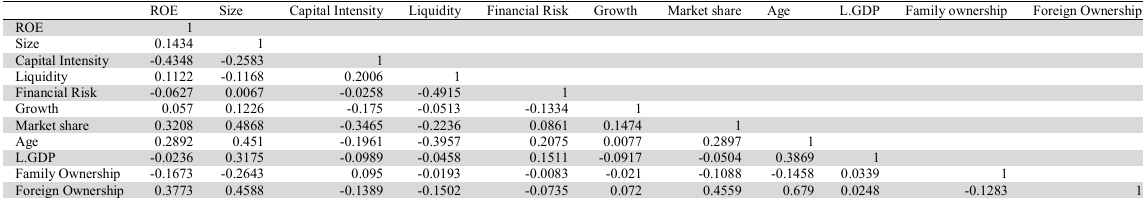
Correlation Matrix ROE Size Capital Intensity Liquidity Financial